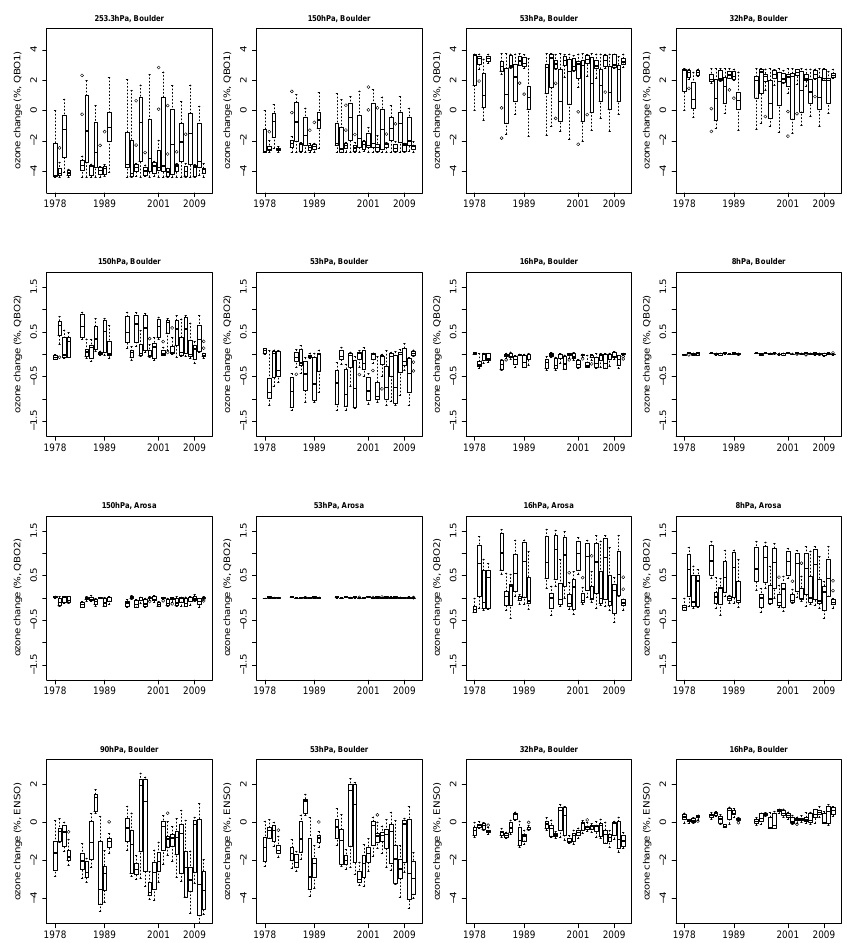
Fig. 8. Monthly contributions of covariates QBO1, QBO2 and ENSO for Boulder, QBO2 and ENSO for Arosa (covariates indicated in y-labels) to changes in ozone profiles for selected altitudes (indicated on top of each plot with station name). The contributions (%) are grouped by year and displayed as boxplots.